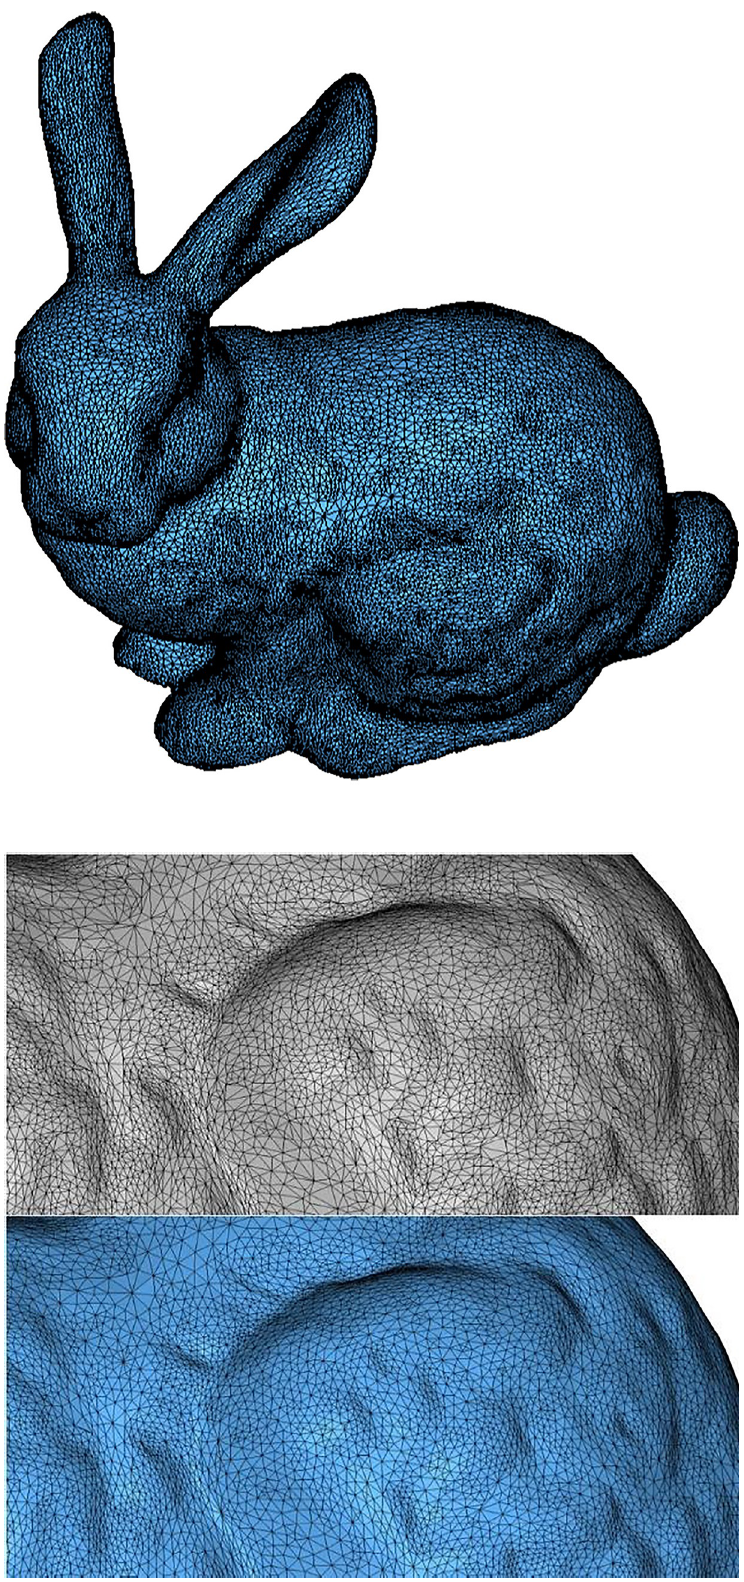
Fig 15. a) Initial mesh of Example 5; b) local comparison of mesh before(up) and after(down) EAS